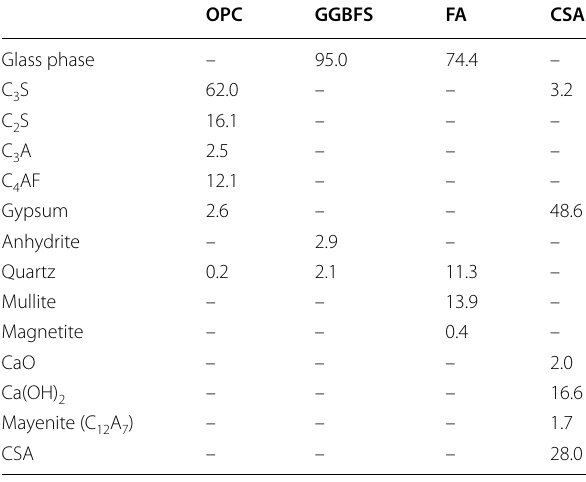
Table 2 Mineralogical phase composition of raw materials.